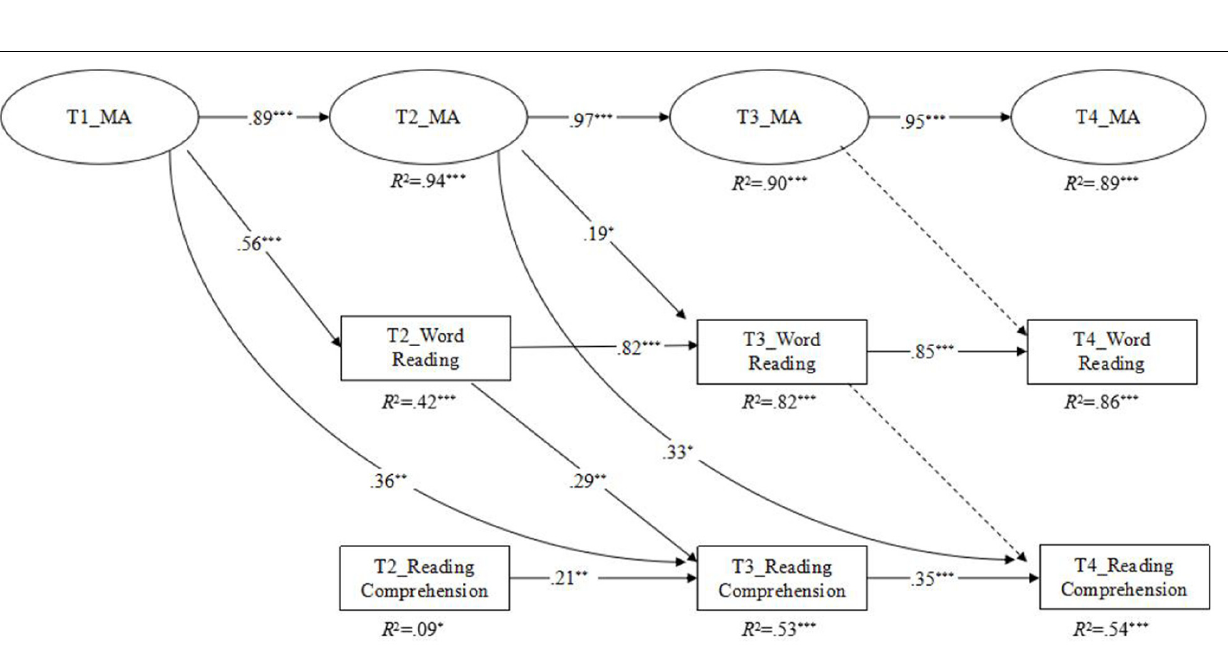
FIGURE 3 | The longitudinal mediation model to address the mediation of word reading in the relationship between MA and RC. The measurement model and the control variables are not shown here to simplify the representation of the model. MA, morphological awareness. Dashed lines indicate non-significant paths. ∗ p < 0.05, ∗∗ p < 0.01, ∗∗∗ p < 0.001,